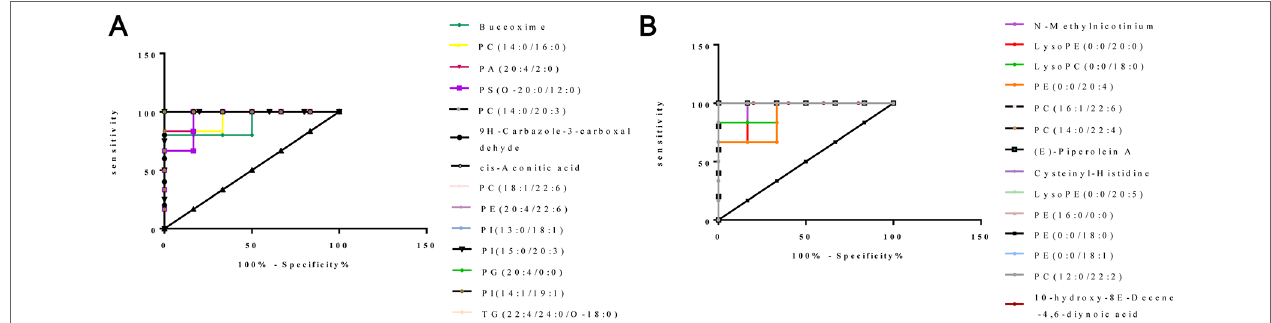
FIGURE 4 | ROC curves of 28 potential biomarkers from kidney in CKD rats. (A) ROC analysis of 14 upregulated biomarkers. (B) ROC analysis of 14 downregulated